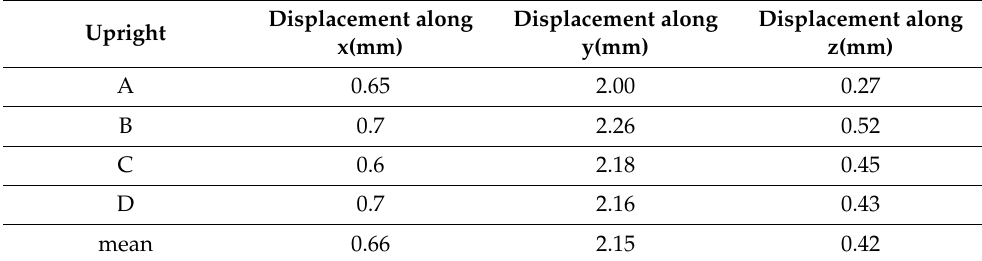
Table 2. Stacking test